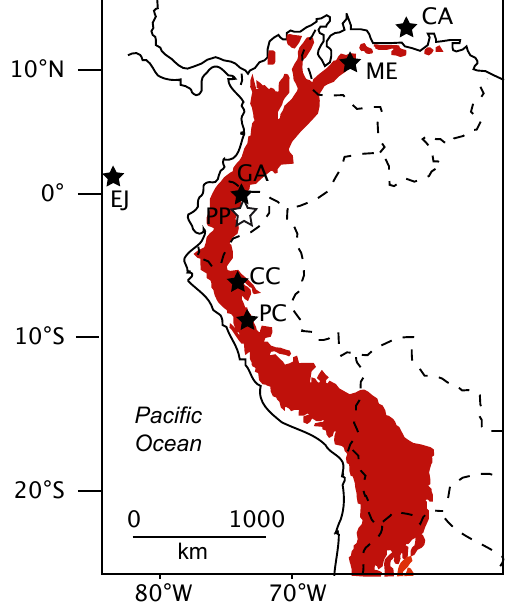
Fig. 1. Map of western South America showing the tropical Andes (in red) and the locations of records discussed in the text (EJ, lake of El Junco; CA, Cariaco Basin; ME, Andes of Merida; GA, bog of Guandera; PP, bog of Papallacta; CC, Cascayunga Cave, PC, lake of